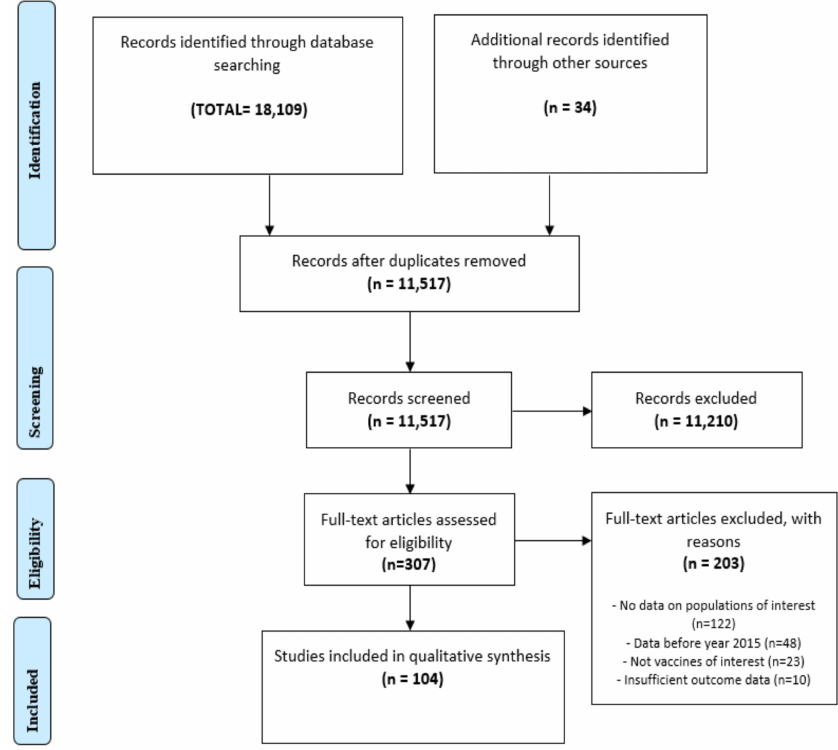
Figure 1. Flow diagram of study